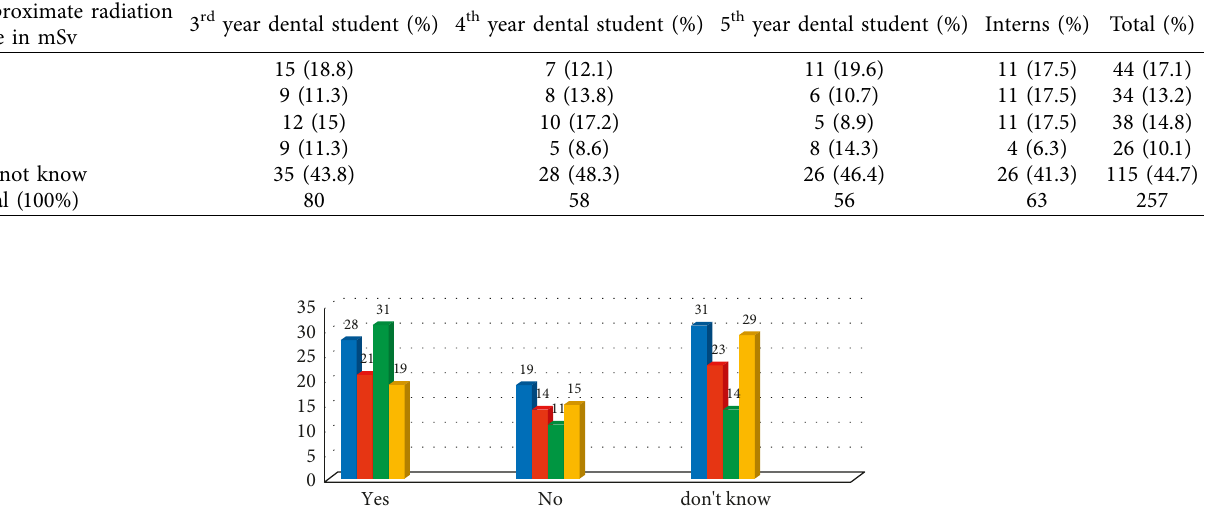
Table 1: Awareness of participants of approximate radiation dose, in mSv of chest X-ray. Approximate radiation